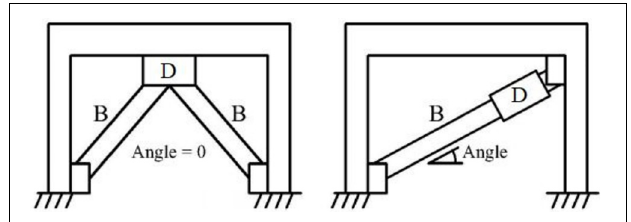
FIGURE 4 | Supporting brace configuration (B = brace; D = damper).